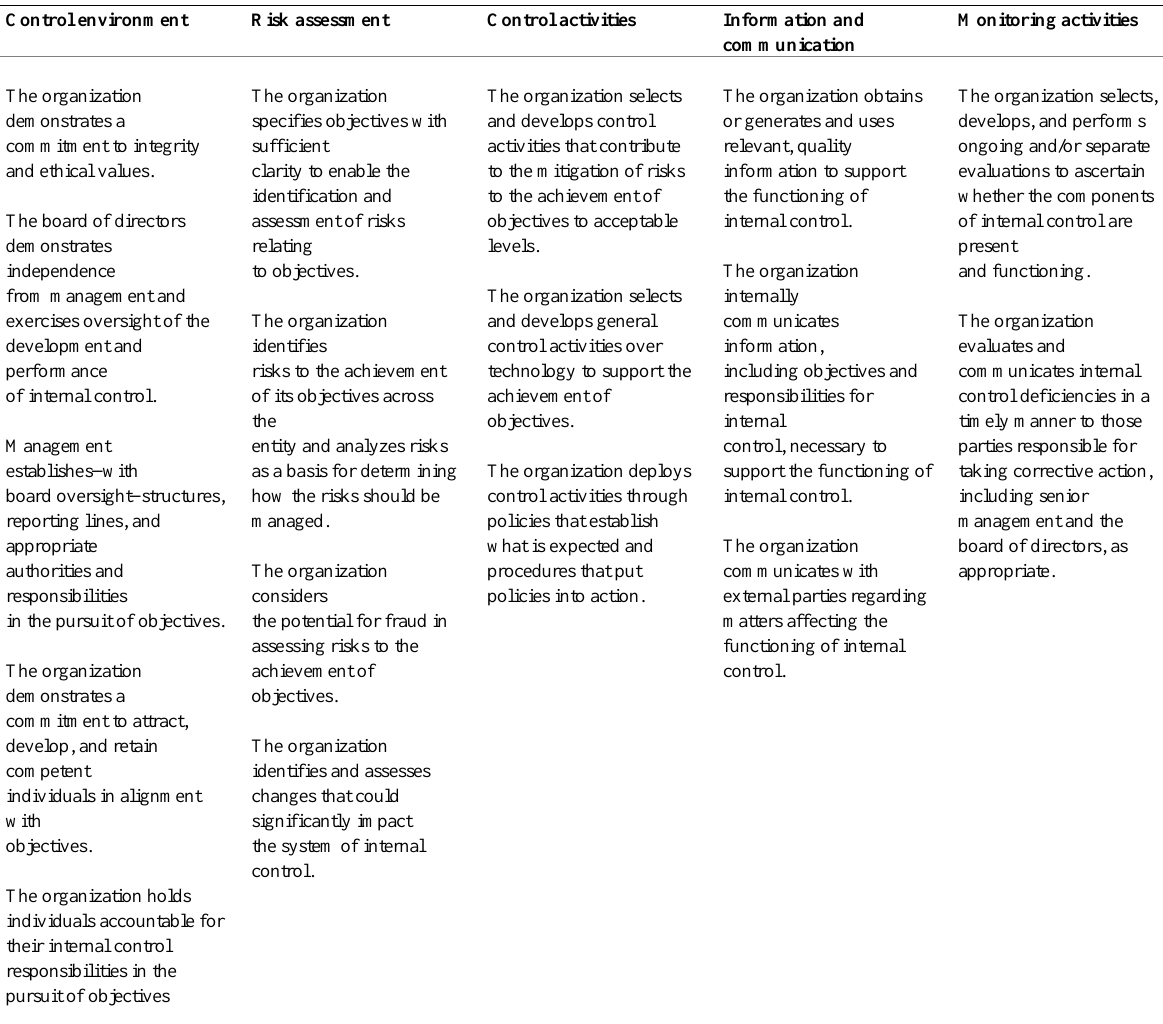
The five components of internal control and related fundamental principles are shown at the table below. Table 1: The five components of internal control and related 17